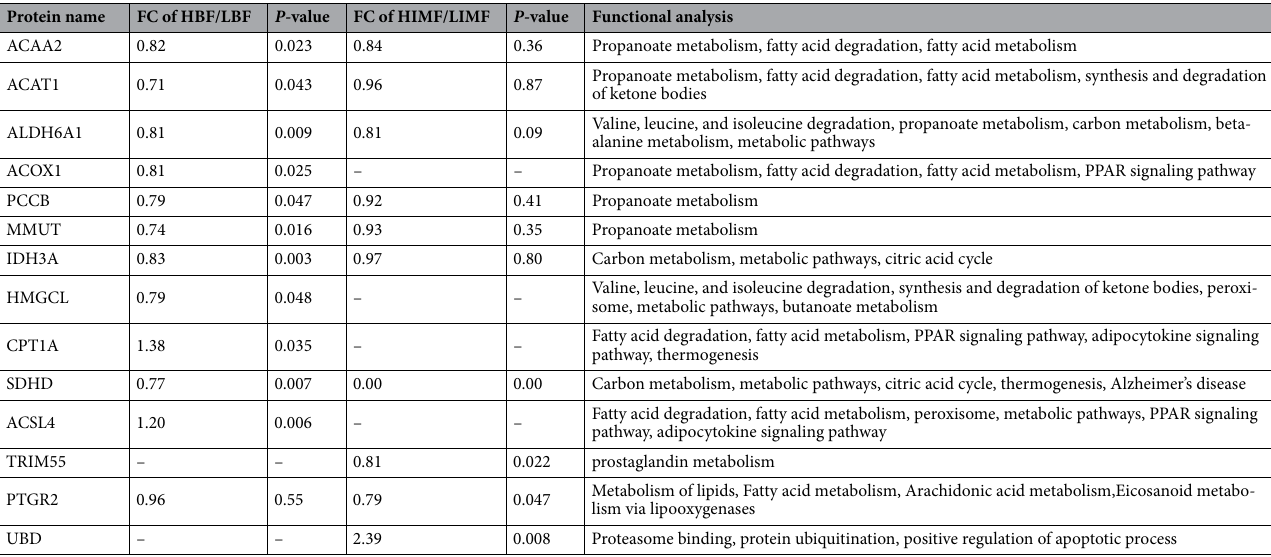
Table 3. Potential key candidate proteins identified from the proteome. LBF low backfat thickness, HBF high backfat thickness, HIMF high intramuscular fat, LIMF low intramuscular fat, log 2 FC log 2 fold change, FDR false discovery